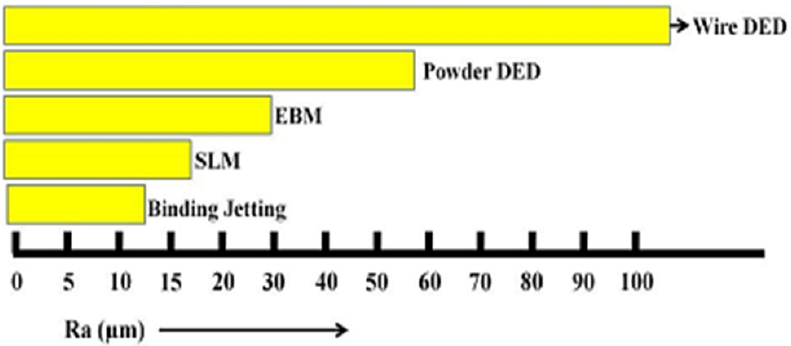
Figure 17. Comparison between the surface roughness produced by the various manufacturing processes [139].